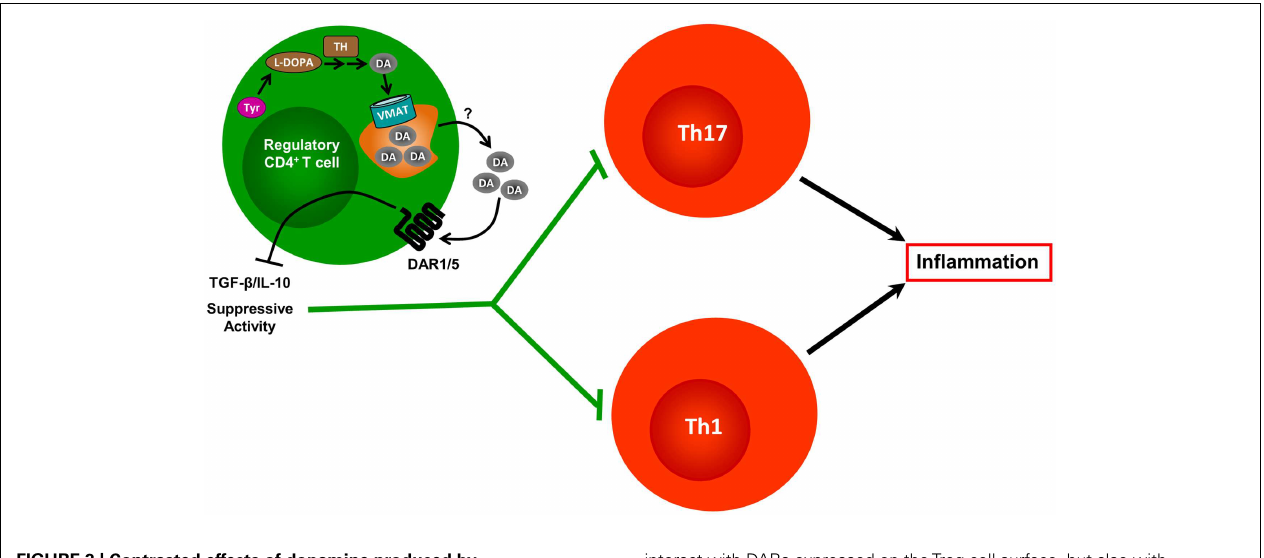
FIGURE 3 | Contrasted effects of dopamine produced by regulatoryT cells .Tregs constitutively expressTH and contain substantial amounts of DA.They also expressVMAT-1 andVMAT-2, which allows them to accumulate DA in vesicular stores. In response to yet unknown physiological stimuli,Tregs release DA, which can